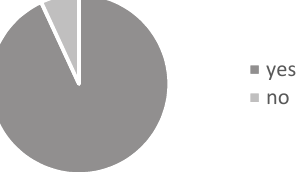
Figure A22. Noticing the intervention, second survey (87 individuals).